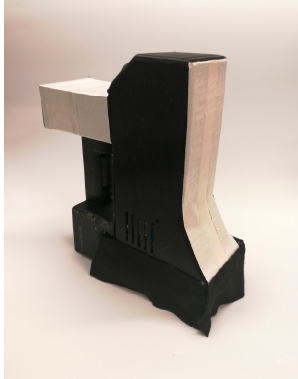
Figure 1. Handheld hyperspectral imaging scanner (LeafSpec). The hardware of LeafSpec consists of four main components: a camera sensor, a scanning mechanism, a light box, and an ARM® based microcontroller.